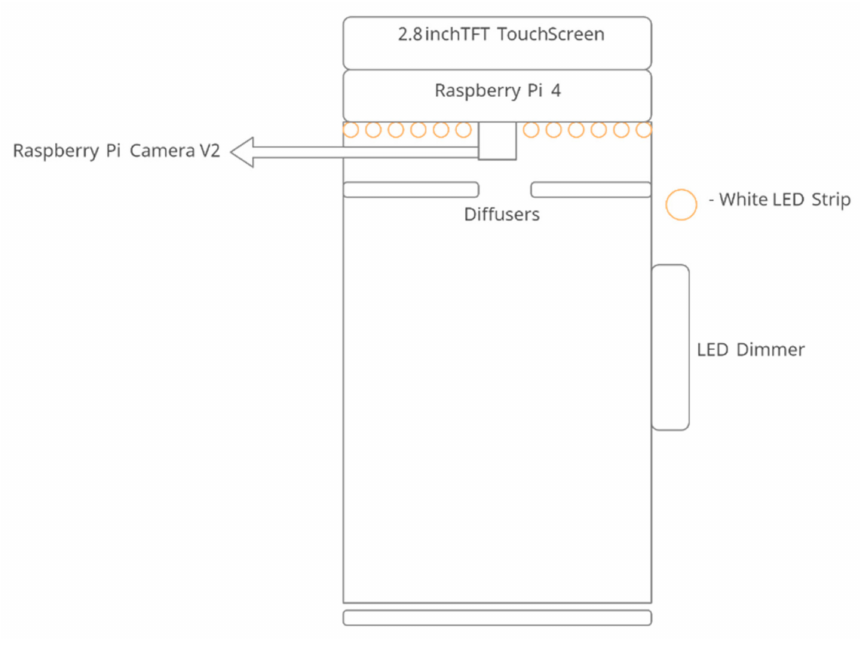
Figure 2. Schematic of the HSI system.